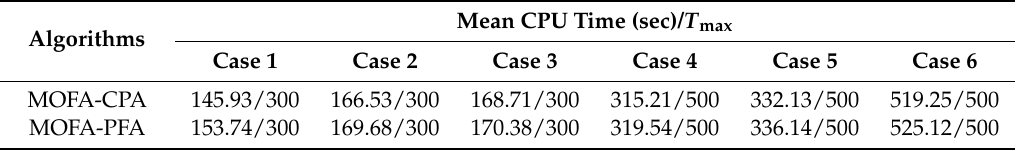
Table 11. Comparison of mean CPU time of two algorithms for Cases